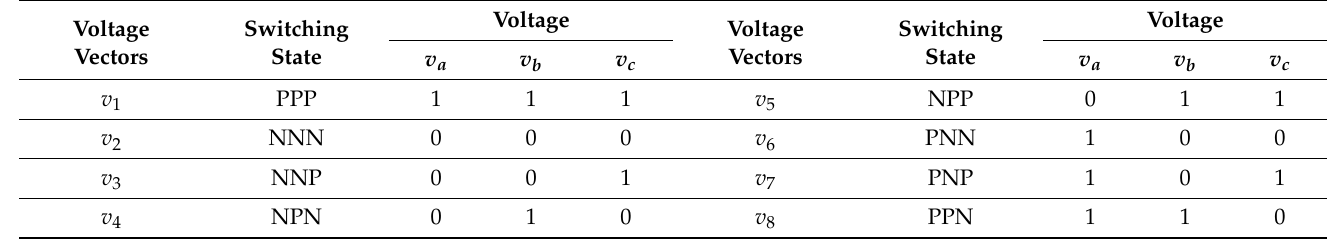
Table 2. Input voltage according to the switching state of the two-level four-leg inverter.